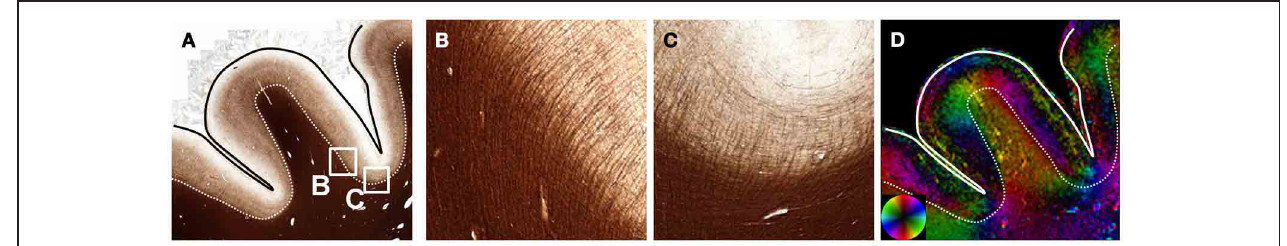
FIGURE 5 | Cortical Structure. The myelinated fibers of the cortex (A) are predominantly oriented perpendicular to the cortical surface. Within the gyrus, white matter fibers are oriented along the main axis of the gyrus. However, (B) fibers entering the cortex from the white matter turn at nearly right angles as evidenced by the abrupt changes in orientation